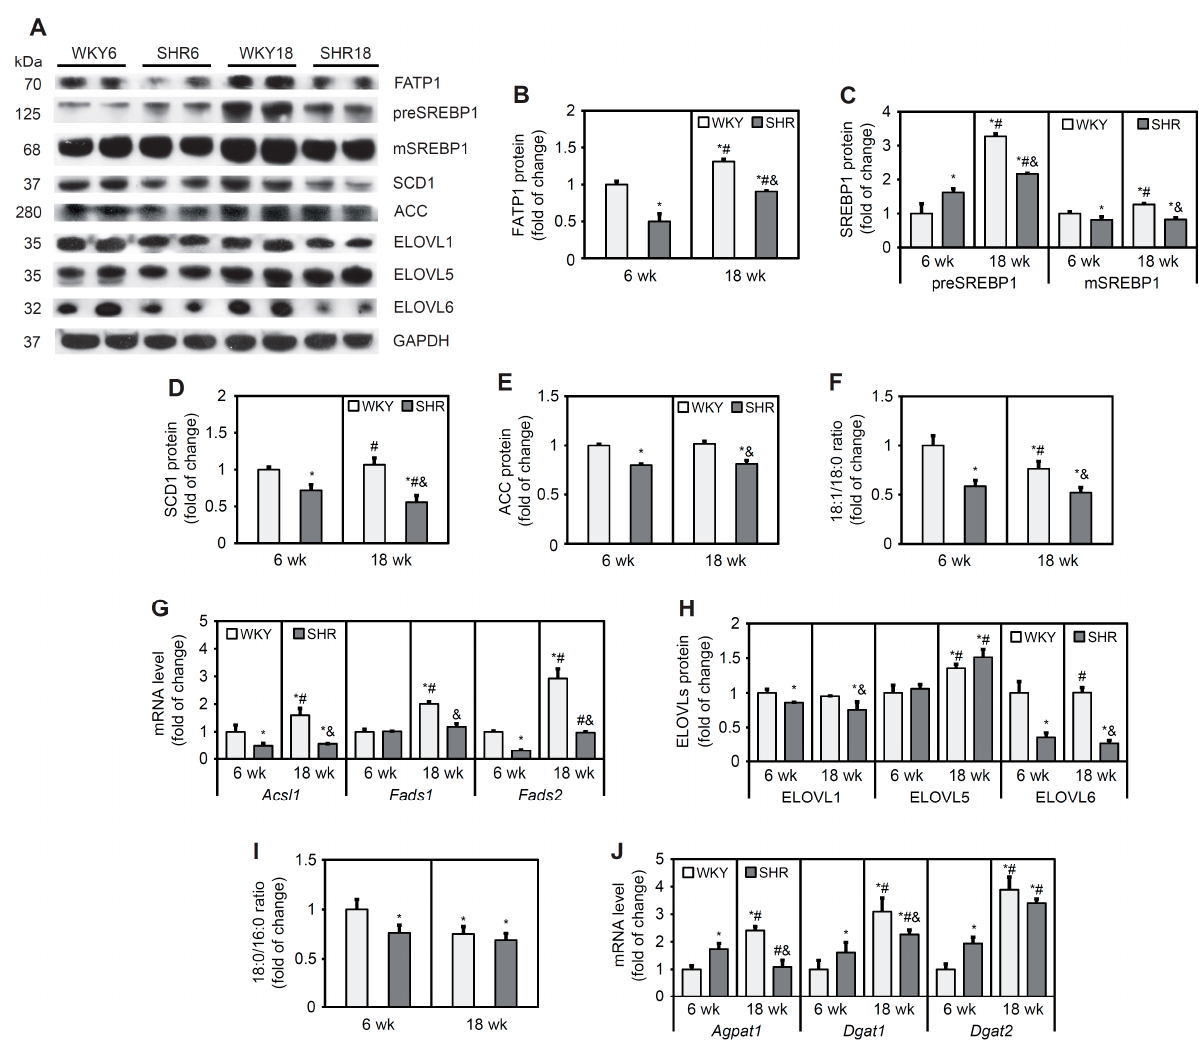
Figure 3. Expression of lipogenic factors and desaturation (18:1n-9/18:0) and elongation (18:1n9/18:0) ratios in cardiomyocytes in WKY rats and SHRs at 6 and 18 weeks of age. Protein levels of fatty acid transport protein 1 (FATP1) ( A , B ), premature and mature forms of sterol regulatory element-binding protein 1 (preSREBP1 and mSREBP1, respectively) ( A , C ), stearoyl-CoA desaturase 1 (SCD1) ( A , D ), acetyl-CoA carboxylase (ACC) ( A , E ), and elongases (ELOVLs) ( A , H ) were determined by Western blot. Acsl1 , Fads1 , Fads2 , Agpat1 , Dgat1 , and Dgat2 mRNA levels ( G ) were measured by real-time PCR. Palmitate, stearate, and oleate levels in cardiac total lipid extracts were measured by gas–liquid chromatography ( F , I ). The results are expressed as mean ± SD. n = 10; ( J ) in the case of Western blot analysis LV form 5 rats were merged in one sample and 3 different gels were run. * p < 0.05, vs. WKY6 group; # p < 0.05, vs. SHR6 group; & p < 0.05, vs. WKY18 group. Expression of the Acsl1 gene, which encodes acetyl-coenzyme A (CoA) synthetase, was downregulated in SHRs compared with WKY rats at 6 and 18 weeks of age (Figure